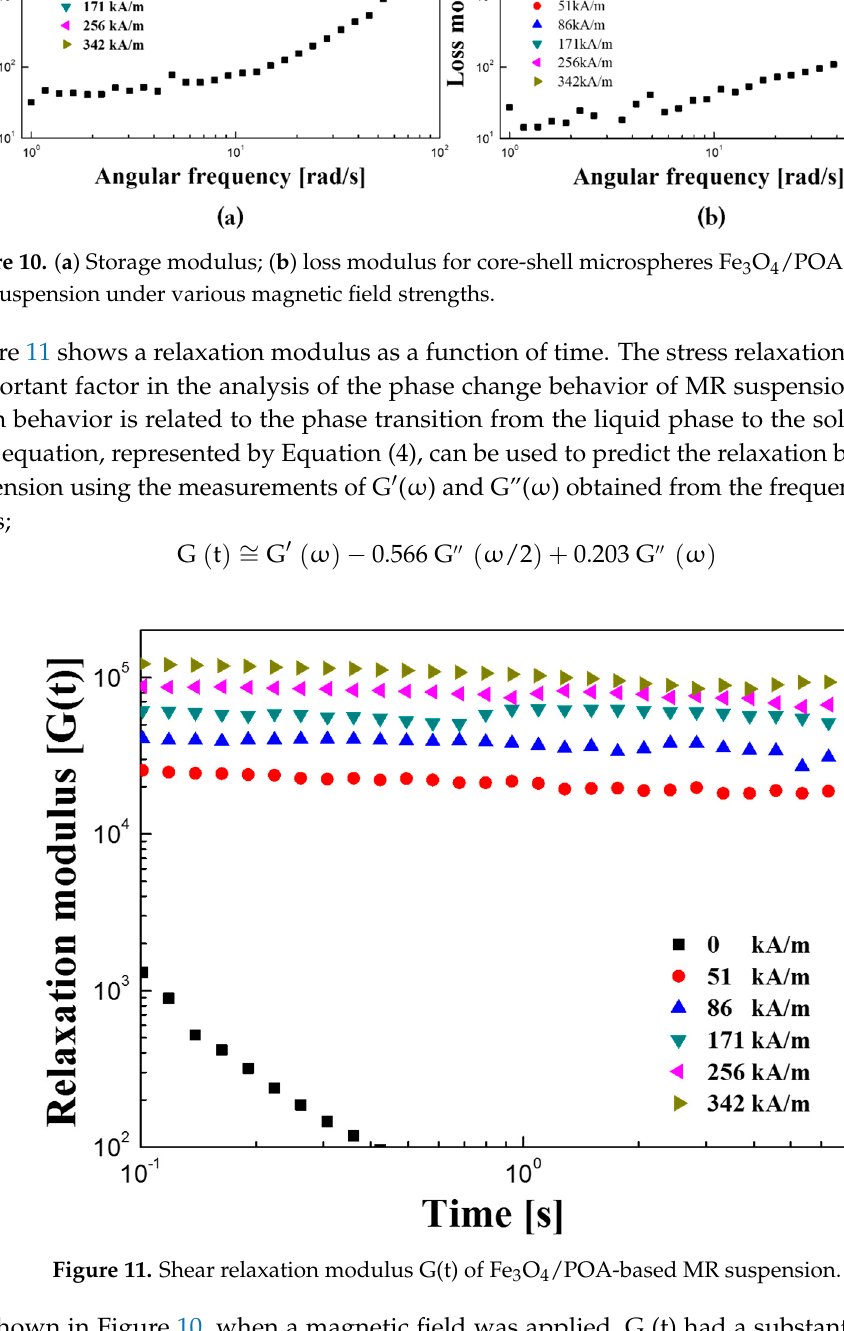
Figure 9. Amplitude sweep dependence of ( a ) storage modulus (G’) and ( b ) loss modulus (G’’) for Fe 3 O 4 / POA-based MR suspension.